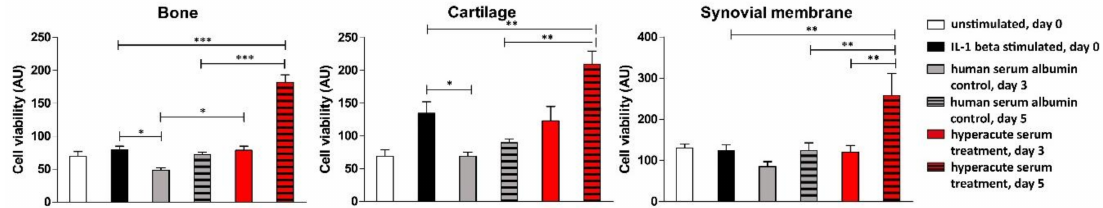
Figure 4. Cell viability in bone, cartilage, and synovial membrane. Hyperacute serum treatment had a positive e ff ect on the cell viability of cartilage, bone, and synovial membrane tissues during a 5 days long culture period, n = 12. The significance level was p < 0.05, where * means that the p -value was between 0.05 and 0.01, ** means that the p -value was between 0.01 and 0.001, and *** means that p -value was lower than